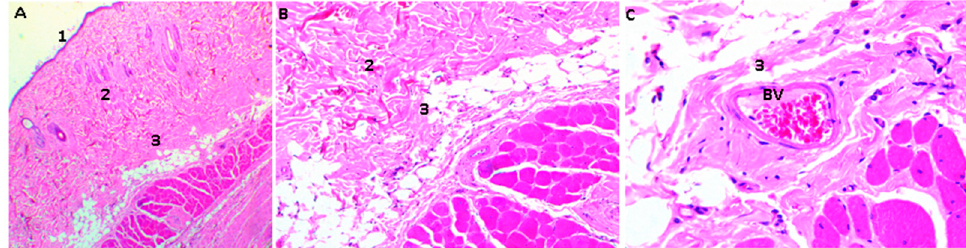
Figure 8. Rat skin sample implanted with collagen film. 1: Epidermis, 2: Dermis, 3: Subcutaneous cellular tissue. Three corresponds to the implantation area, BV: Blood vessel. Hematoxylin-Eosin Technique. Image ( A ) is at 4× magnification, Image ( B ) at 10×, and Image ( C ) at 40×.